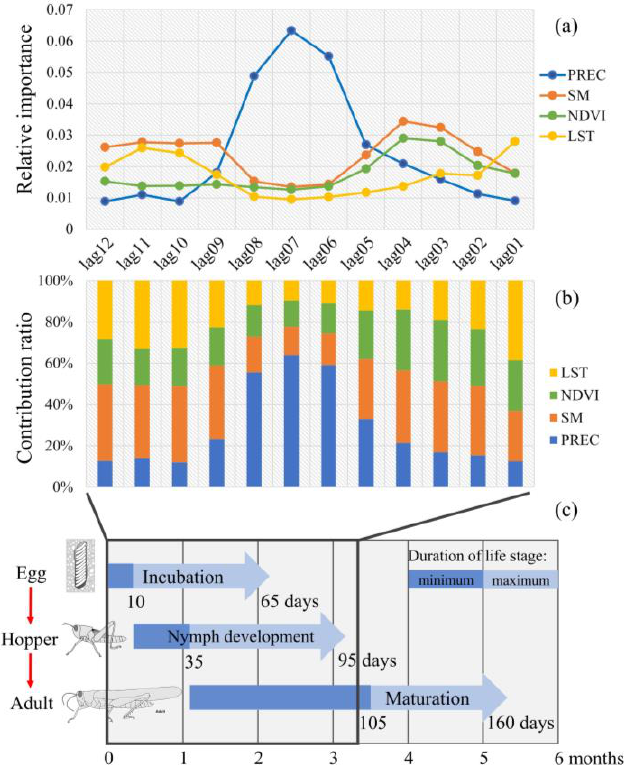
Figure 9. ( a ) Relative importance and ( b ) contribution ratio of dynamic indicators in ( c ) desert locust life sequences of desert locust [12].